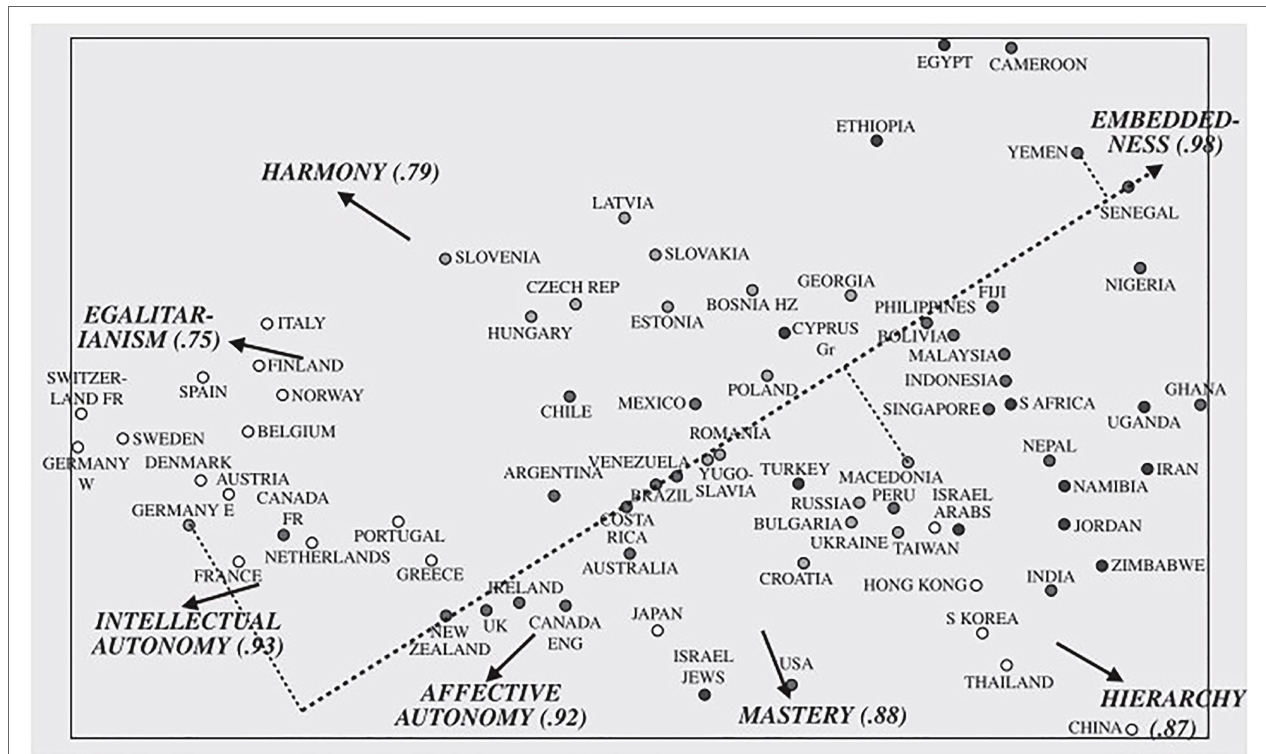
FIGURE 3 | Cultural Value Orientations from 76 National Groups. The figure represents cultural value orientations from 76 national groups based on the combined teacher and college student samples. From Schwartz (2006). The figure has been used with the permission of the